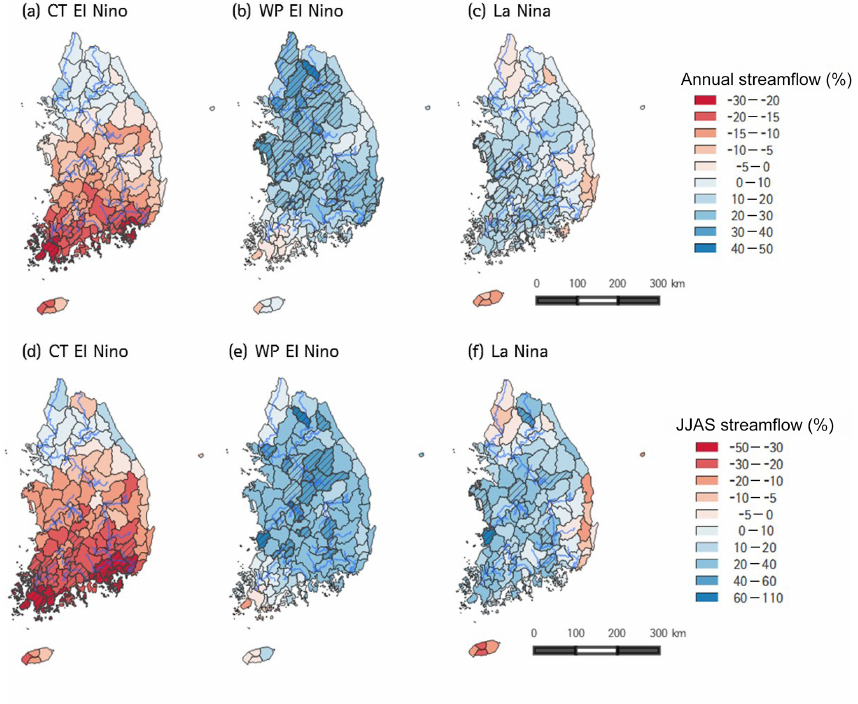
Figure 6. Same as Fig. 5, but for